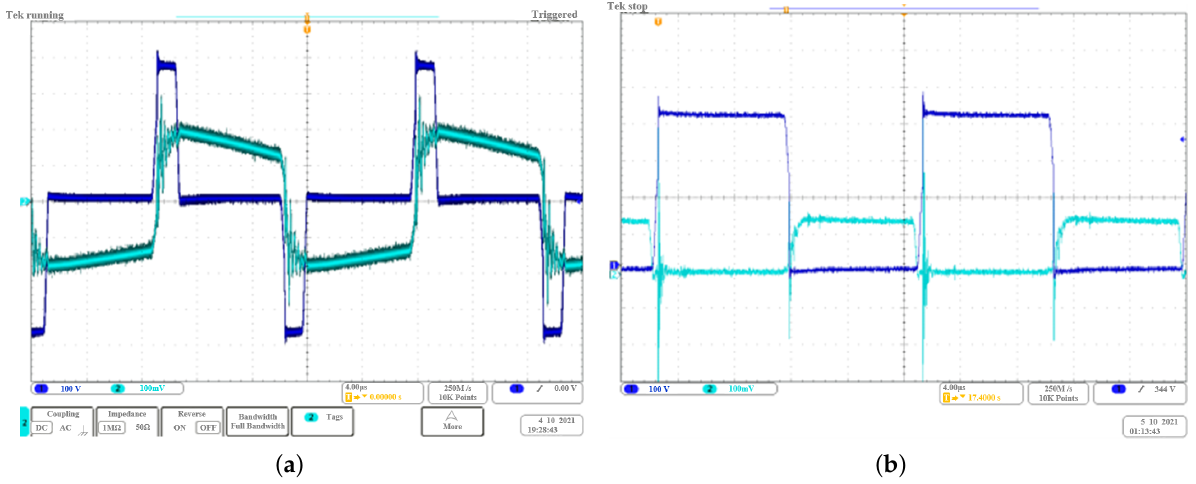
Figure 19. ZVS waveform of the power module. ( a ) The waveform of the voltage difference at the midpoint of the H-bridge. ( b ) The waveform of drain-source voltage and driving voltage of